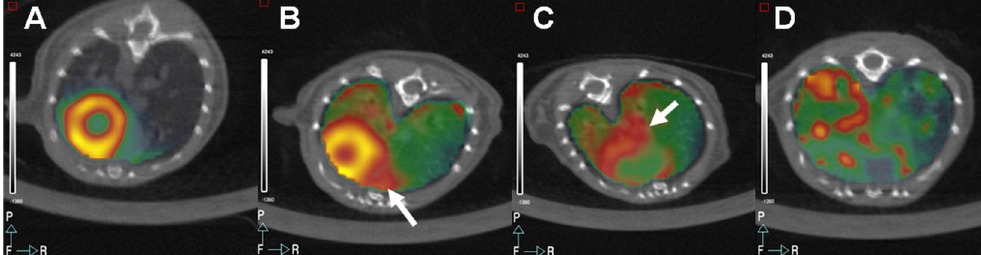
Figure 4. Lung inflammation visualized by 18 F-FDG-PET. (A) Control PET scan after regular diet in a non–LPS-challenged animal. Lungs do not show 18 F-FDG uptake. (B–D) LPS-challenged animals after two days of ketogenic diet. (B) Null suppression of myocardial uptake. (C) Partial suppression of myocardial uptake. In the case of null or partial suppression, it is much harder to distinguish inflammation from myocardial spillover (arrows). (D) Complete suppression improves hot areas identification.